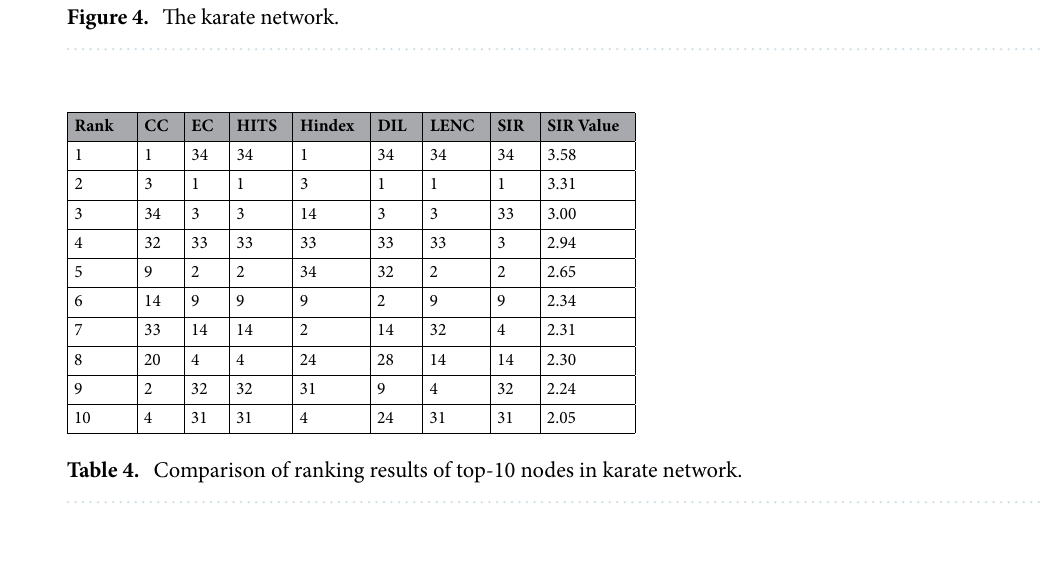
Figure 4. The karate network.